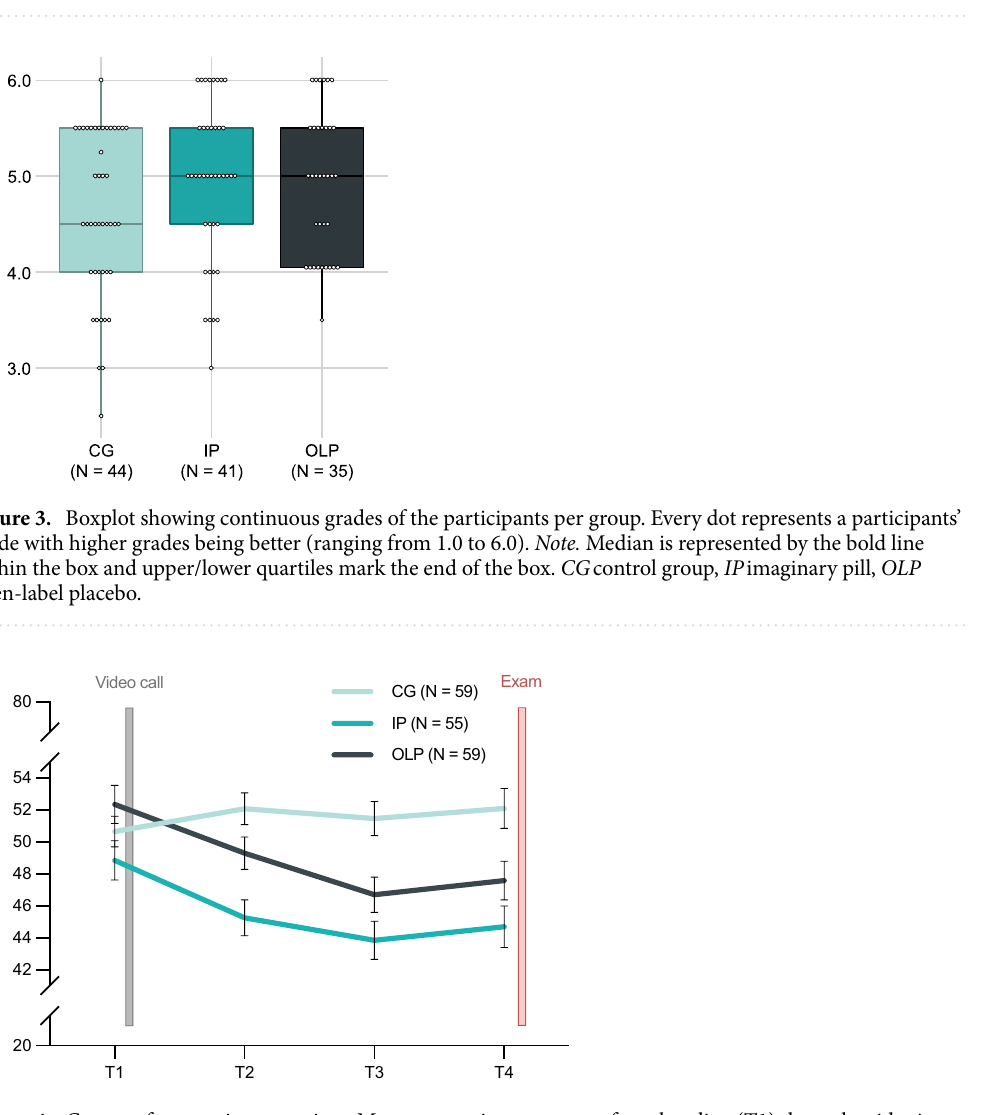
Figure 4. Course of test anxiety over time. Mean test anxiety per group from baseline (T1) through midpoints (T2, T3) to study endpoint (T4). Note. Error bars represent standard error of the mean. CG control group, IP imaginary pill, OLP open-label